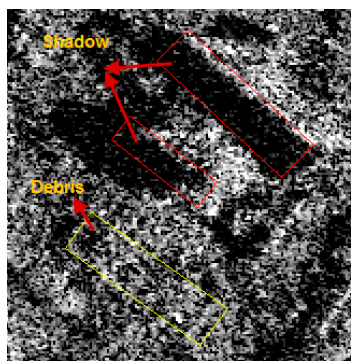
Figure 13. Examples of shadows of standing buildings (red rectangle) and collapsed building (yellow rectangle) debris in building footprints in the SAR image.